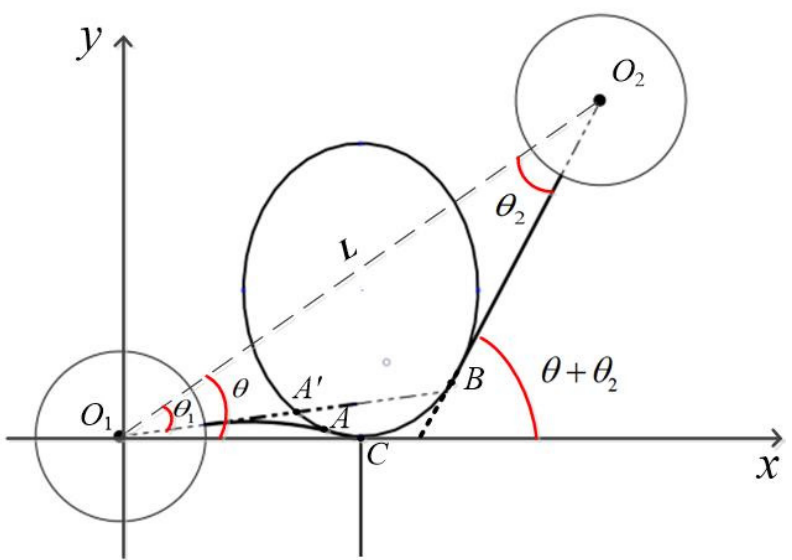
Figure 12. Schematic diagram of the interaction of flexible fingers with pineapple. ( a ) Before the right finger contact. ( b ) After the right finger contact.